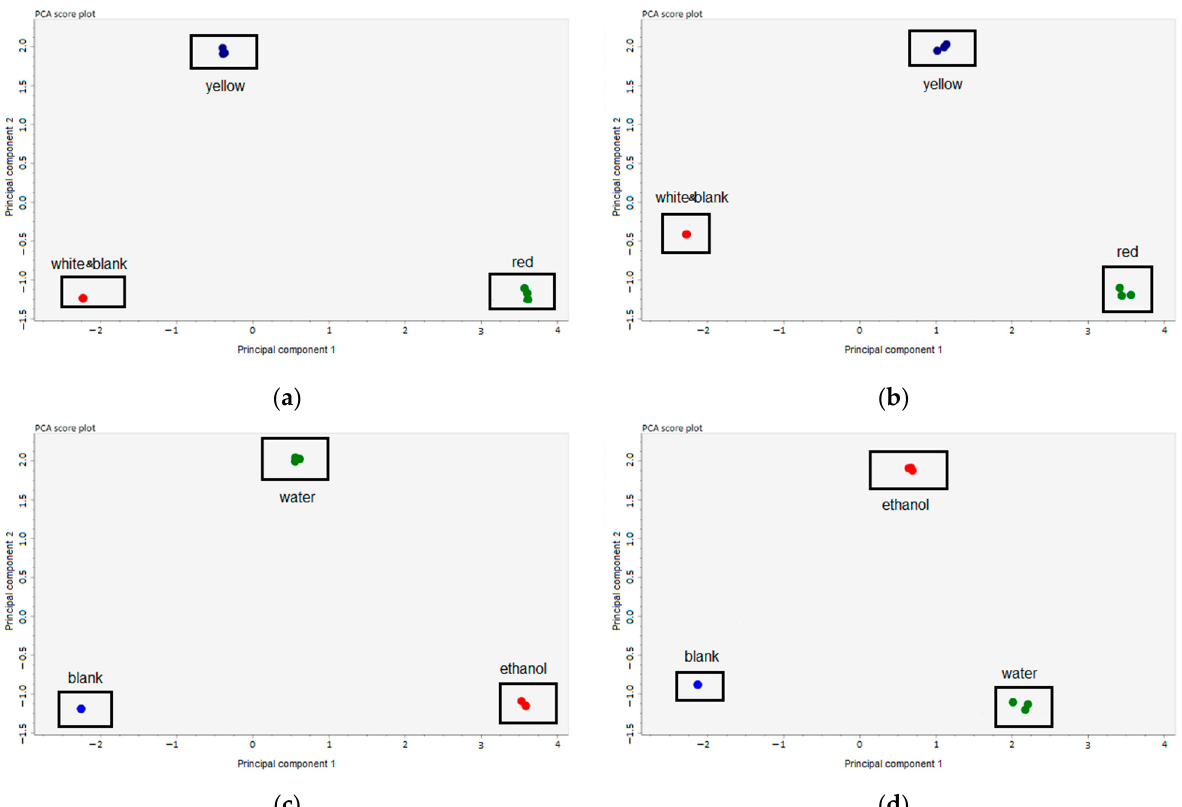
Figure 1. PCA analysis results: ( a ) ethanolic extracts from red, yellow, and white onion husks; ( b ) water extracts from red, yellow, and white onion husks; ( c ) water and ethanolic extracts from red onion husk; ( d ) water and ethanolic extracts from yellow onion husk.